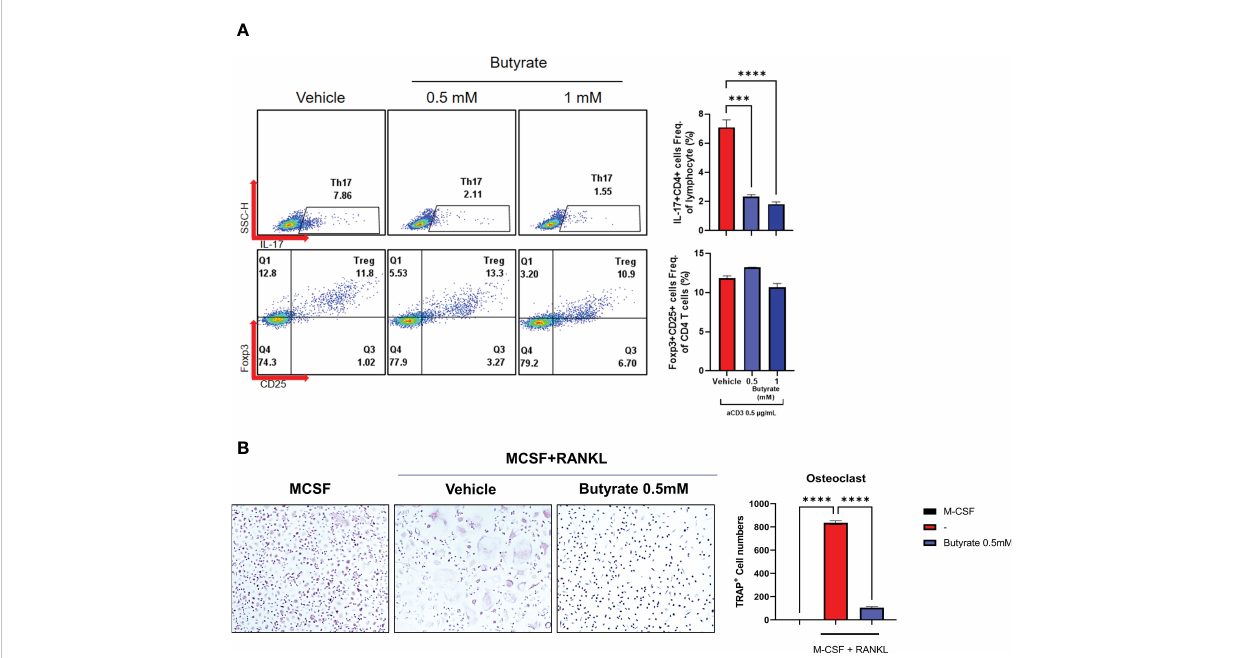
FIGURE 4 Effects of butyrate on the CD4 + T cell differentiation and osteoclastogenesis of axSpA patient-derived PBMCs. (A) PBMCs (1 x 10 ^6 cells) were obtained from axSpA patients (N = 4). These were cultured with butyrate (0.5 or 1 mM), with anti-CD3 Ab (0.5 m g/mL) for 72 h. CD4 + IL-17A + T cell and CD4 + CD25 high Foxp3 + T cell differentiation was measured by fl ow cytometry (presented with representative fl ow cytometry image). (B) PBMCs (1 x 10 6 cells) from axSpA patients were cultured with M-CSF (30 ng/mL) and RANKL (100 ng/mL) with vehicle or butyrate 0.5 mM for 10 – 14 days. The TRAP + multinucleated cells were counted. *** P < 0.001, **** P <